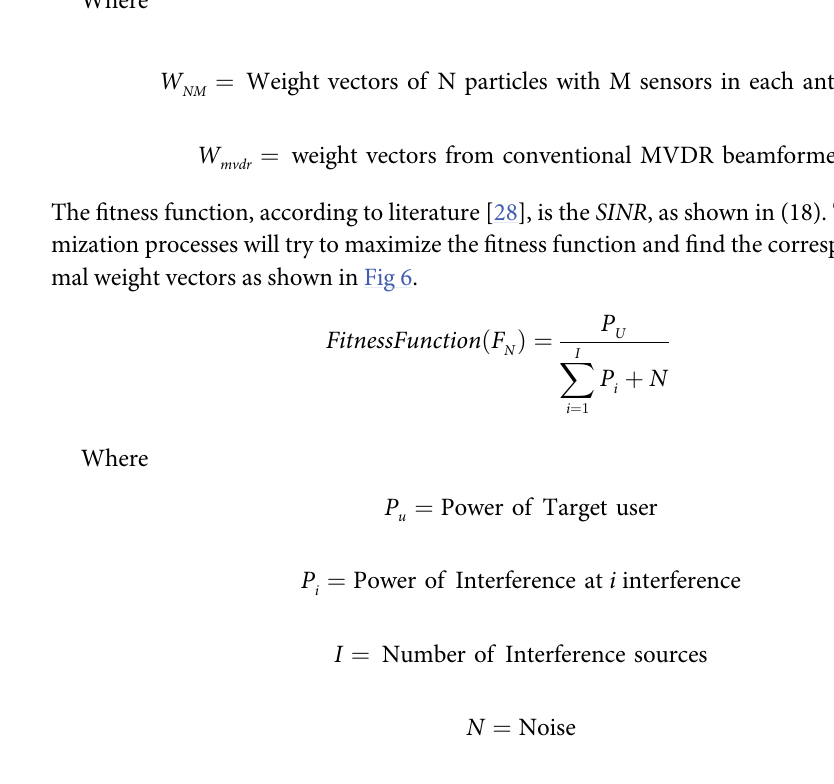
Table 8. Comparison of weight vectors for conventional MVDR, PSO-MVDR, GSA-MVDR, SLGSA-MVDR [28] and ECGSA-MVDR for user at 0° and interferences at 30°. Name